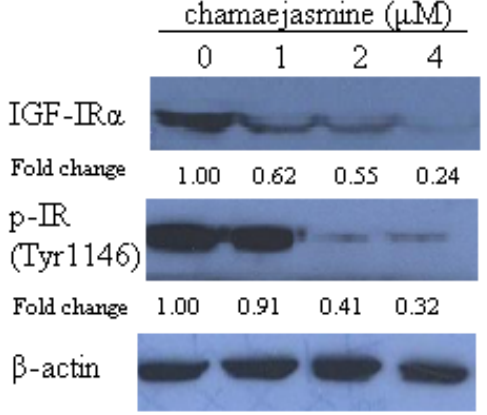
Figure 3. Immunoblotting for IGF-I Receptor α and phospho-IGF-IF (Tyr1131)/Insulin Receptor (Tyr1146) using lysates from HEp-2 cells treated with 0, 1, 2 and 4 μ M chamaejasmine. The blots were stripped and reprobed with anti- β -actin antibody to normalize protein loading. Change was calculated as described in Figure